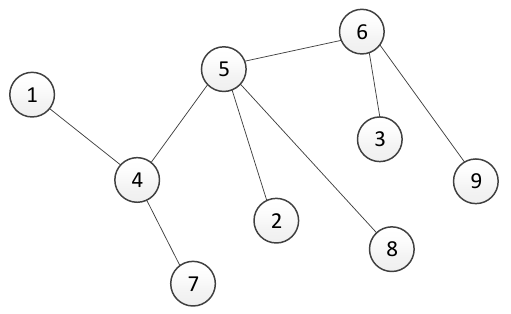
Figure 1. Graph topology of channel A of the system with 9 agents, where numbers represent identification numbers of agents.